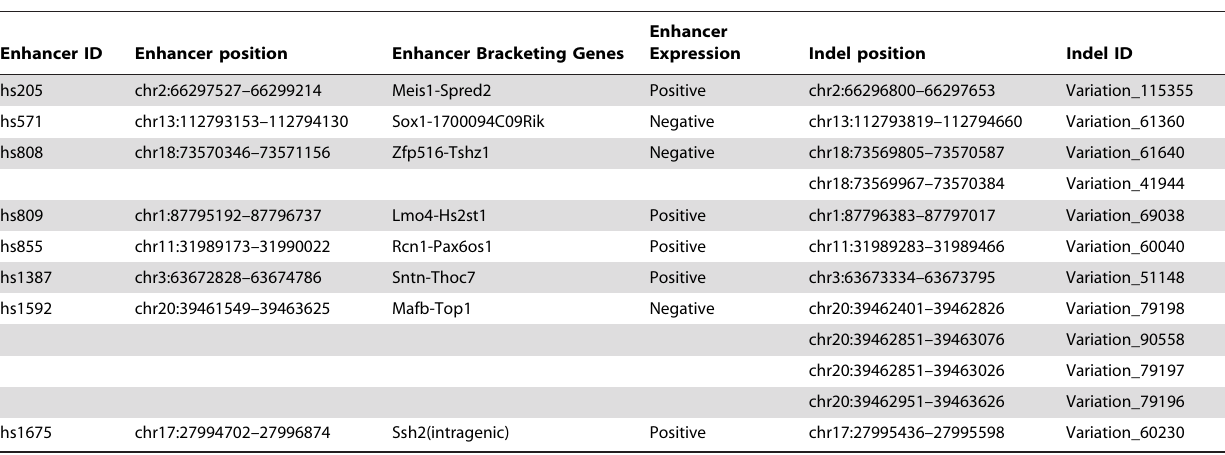
Table 2. VISTA enhancer loci overlapped by ‘‘DGV’’